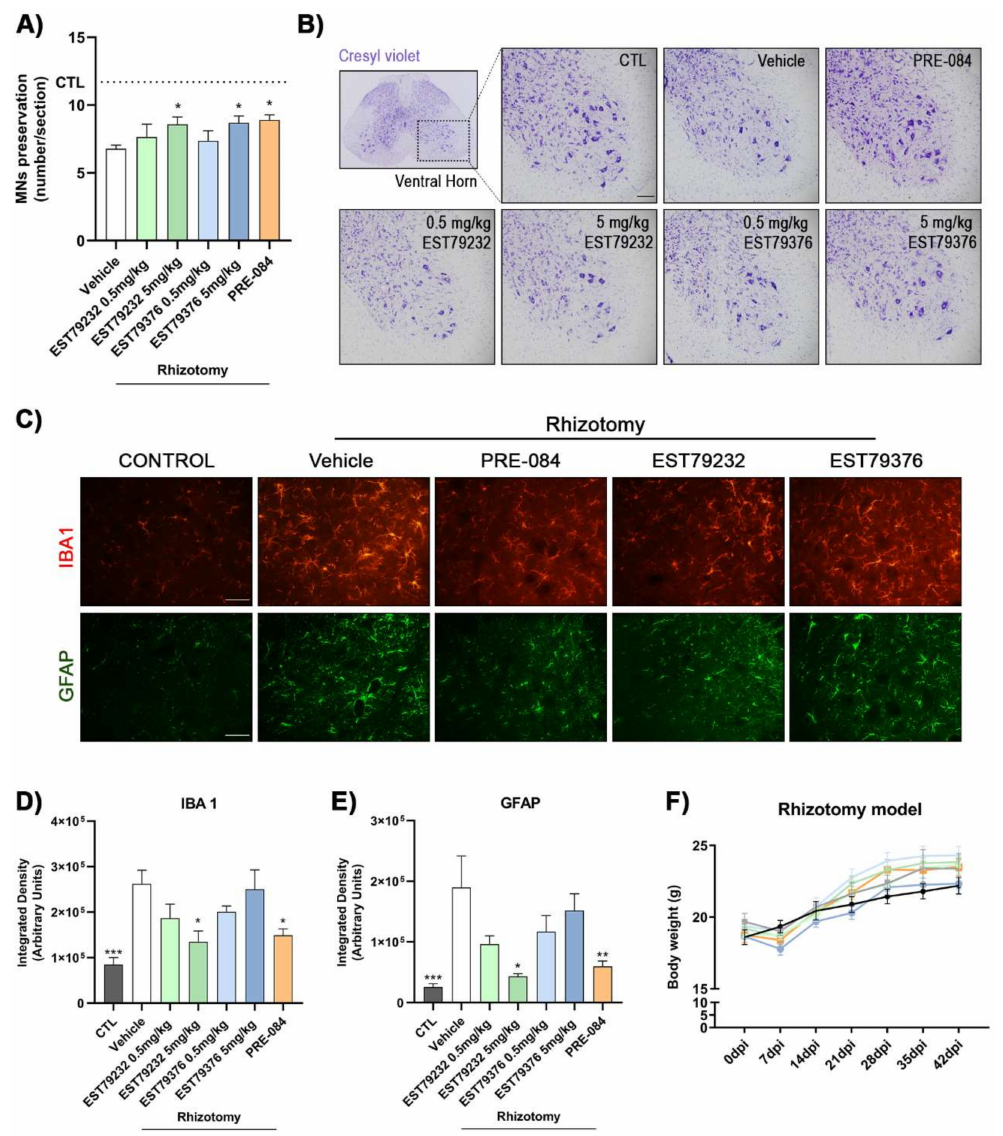
Figure 3. Administration of EST79232 and EST79376 increased MN survival and modulated glia activation after L4-L5 spinal roots injury. ( A ) Plot of number of α -MNs in L4-L5 segments, showing higher number of MNs in mice treated with Sig-1R ligands than in untreated ones. Animals per group: control (CTL), n = 14; vehicle, n = 14; PRE-084, n = 5. EST79232: 0.5 mg/kg, n = 5; 5 mg/kg, n = 6; EST79376: 0.5 mg/kg, n = 5; 5 mg/kg, n = 5. ( B ) Representative images corresponding to ventral horns of L4-L5 cord segments ipsilateral to rhizotomy in female mice with or without Sig-1R ligands treatment at 42 days post-injury (dpi). Scale bar: 100 µ m. C) Representative images of glial reactivity assessed by microglia (IBA1) and astrocytes (GFAP) immunolabeling in the ventral horn of control and rhizotomized mice with vehicle or Sig-1R treatment (PRE-084, EST79232, and EST79376 at dose of 5 mg/kg) at 42 dpi. Scale bar: 50 µ m. ( D , E ) Bar graph showing the integrated density of Iba-1 and GFAP immunolabeling in the ipsilateral ventral horn of spinal cord. n = 6 mice per group. ( F ) Plot of the body weight of rhizotomized mice during the study. All the mice groups presented a mild reduction in the body weight the first week after surgery, then gained weight normally during the follow-up. Data are mean ± SEM, analyzed with one-way ( A , D , E ) or two-way ( F ) ANOVA and Bonferroni’s multiple comparisons test. * p < 0.05, ** p < 0.001, *** p < 0.0001 vs. vehicle rhizotomized